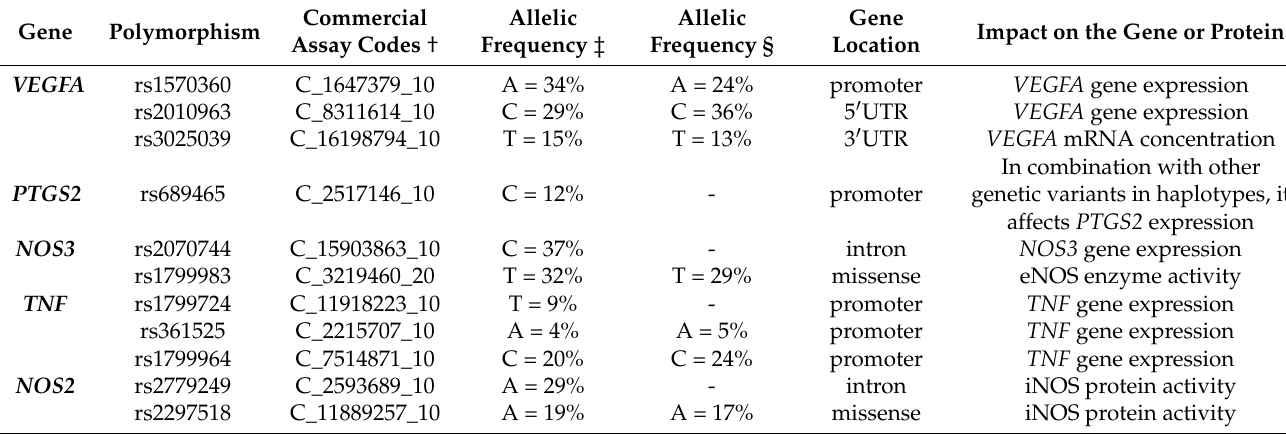
Table A1. General information of the polymorphisms